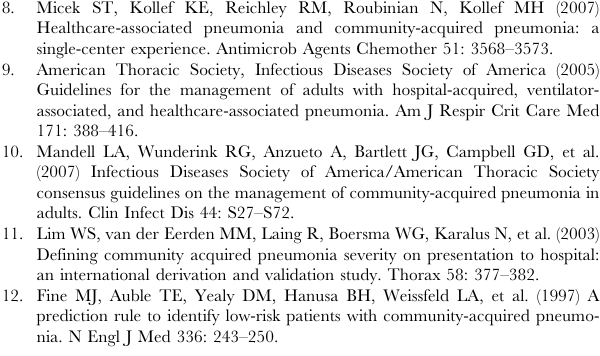
Table S1 Pathogens isolated in respiratory specimens of CAP and HCAP patients a . Table S2 Demographic profiles and clinical character- istics of CAP and HCAP patients with and without concomitant pulmonary tuberculosis within 90 days of admission a . Table S3 Univariate and multivariate logistic regres- sion analysis of predictors associated with concomitant pulmonary tuberculosis within 90 days of admission in hospitalized HCAP and CAP patients a . Table S4 Univariate and multivariate logistic regres- sion analysis of predictors associated with in-hospital mortality in hospitalized CAP and HCAP patients a